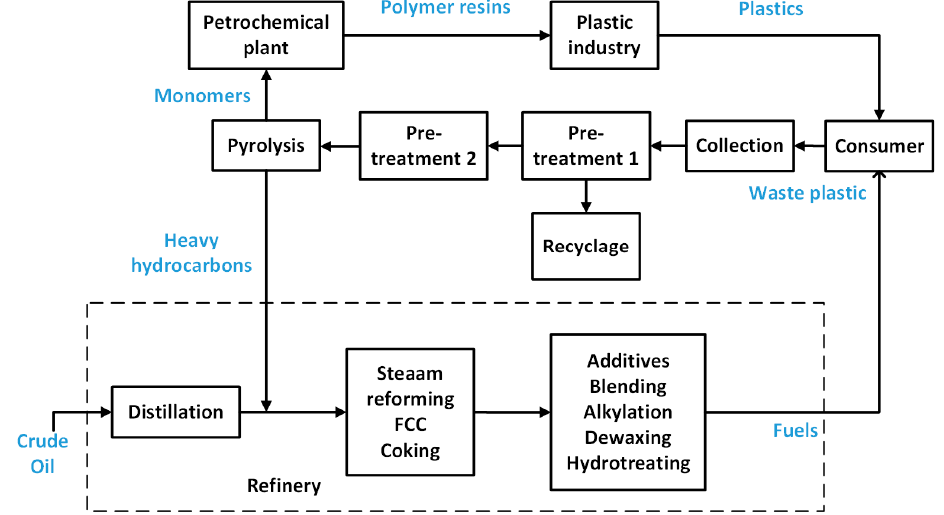
Figure 4. Integration of a plastic waste pyrolysis plant with an oil refinery.